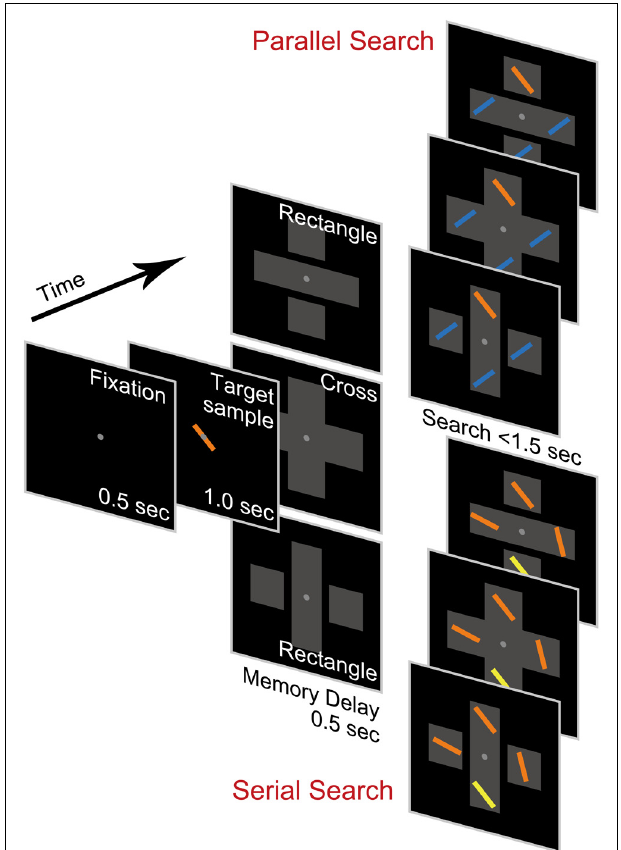
FIGURE 1 |Visual stimuli and behavioral tasks. Tasks consisted of two types: parallel search task (upper) and serial search task (lower). In both task types, observers searched for a target among a stimulus array including four line-shaped stimuli after appearance of the target sample. The target stimulus was distinguished from distractors by color and orientation in the parallel search task but by either color or orientation in the serial search task. In the course of each task trial, task-irrelevant closure objects appeared separately (rectangle condition) or connectedly (cross condition) in the background. For illustration purposes, the stimulus colors were modified from the actual colors used in our experiments.